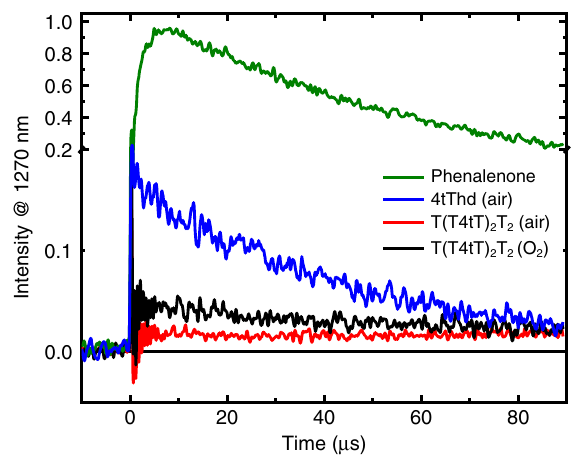
Fig. 3 Time-resolved phosphorescence signals at 1270 nm. Singlet-oxygen decay traces were generated by pulsed photoexcitation (355 nm, 7 ns pulses) of 4tT (blue line), T(T4tT) 2 T 2 (red and black lines), and phenalenone (green line, Φ Δ = 0.98) 52 in O 2 (black line) and air-saturated (blue and red lines) TRIS-buffered D 2 O